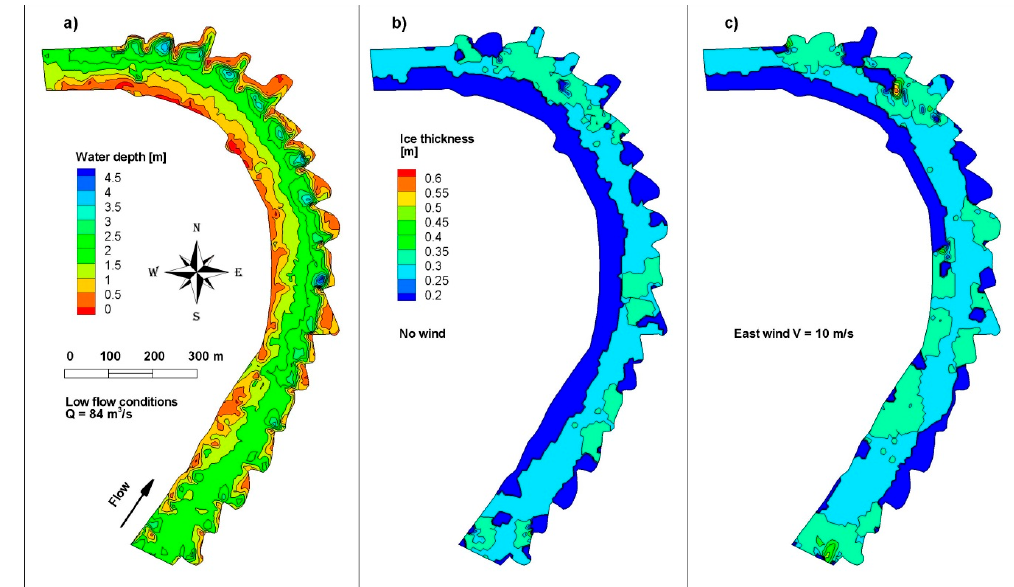
Figure 6. Simulated results of ( a ) water depth, ( b ) ice thickness distribution, and ( c ) ice thickness distribution with an east wind in the Middle Odra River near the Cigacice gauging station (466–468 km), for low flow conditions.